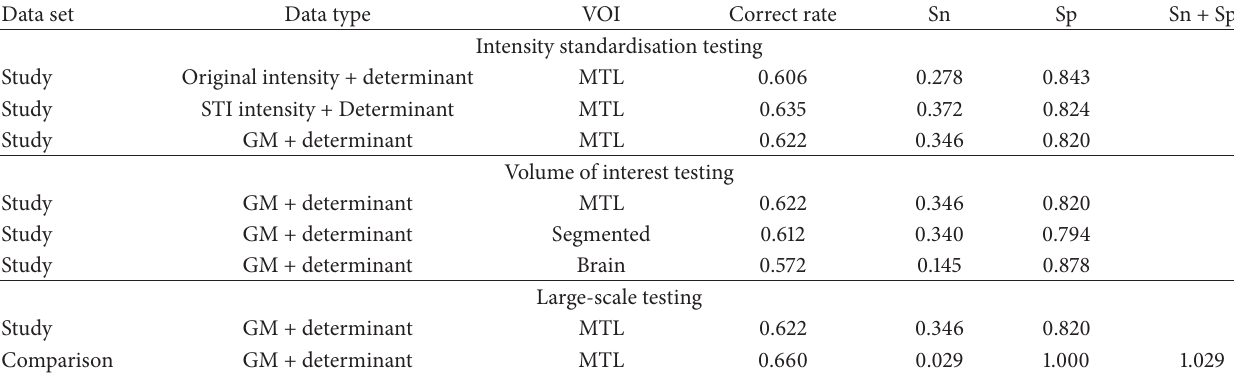
Table 4: Discrimination of MCI progressors versus